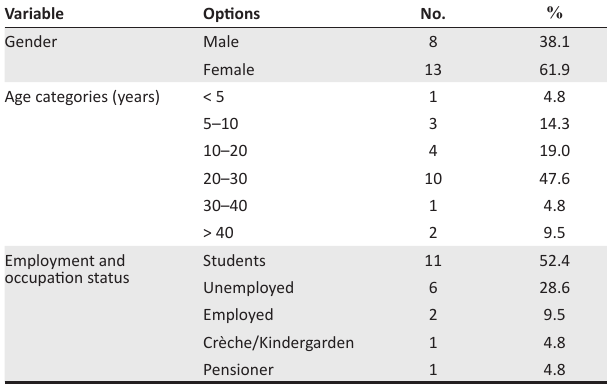
TABLE 1: Socio-demographic profile of the